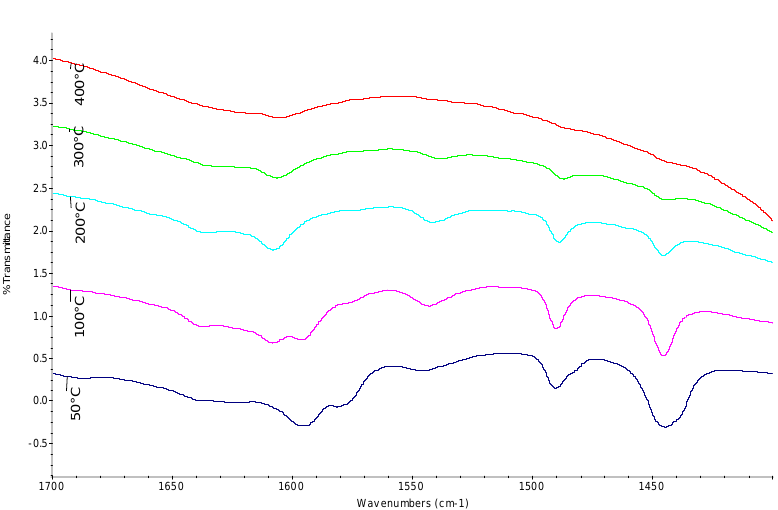
Figure 6. IR spectra of desorption of pyridine from